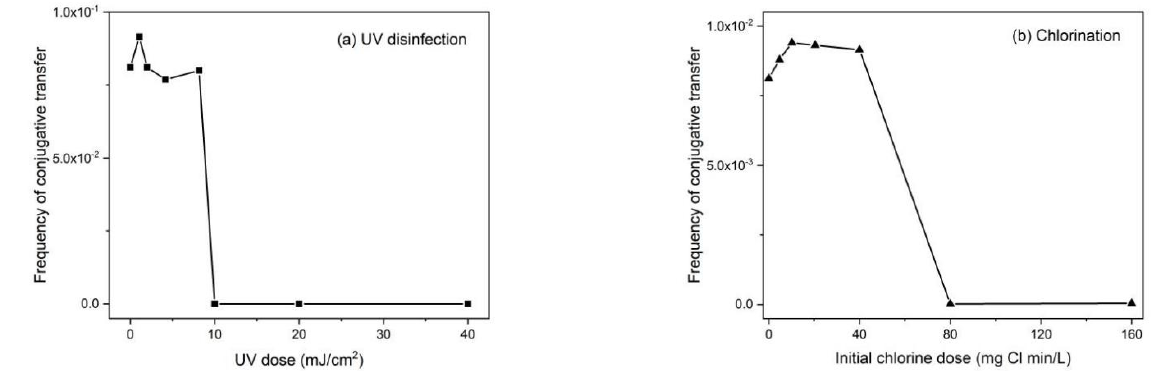
Figure 4. Effect of ( a ) UV disinfection and ( b ) chlorination on the frequency of binding transfer [143].